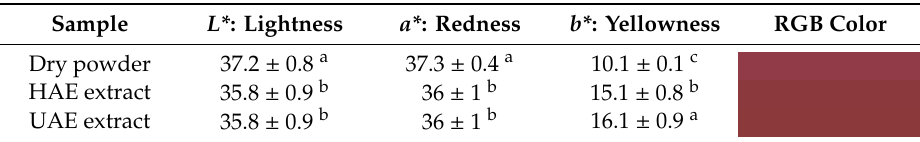
Table 4. Color parameters of the lyophilized red raspberry powder and extracts obtained under the optimized HAE and UAE